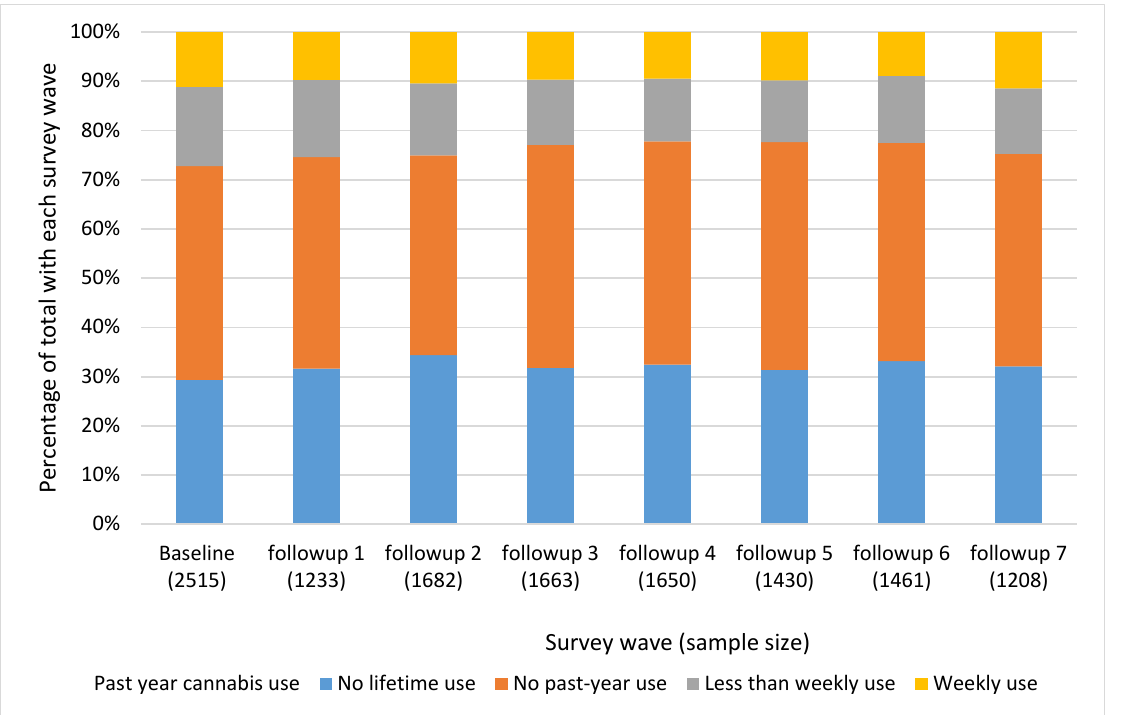
Figure 1. Self-reported cannabis use frequency across VACS survey waves. Notes : Numbers under- neath the survey wave indicate the number of participants who completed each survey wave (e.g., 2515 participants were identified at the baseline assessment).